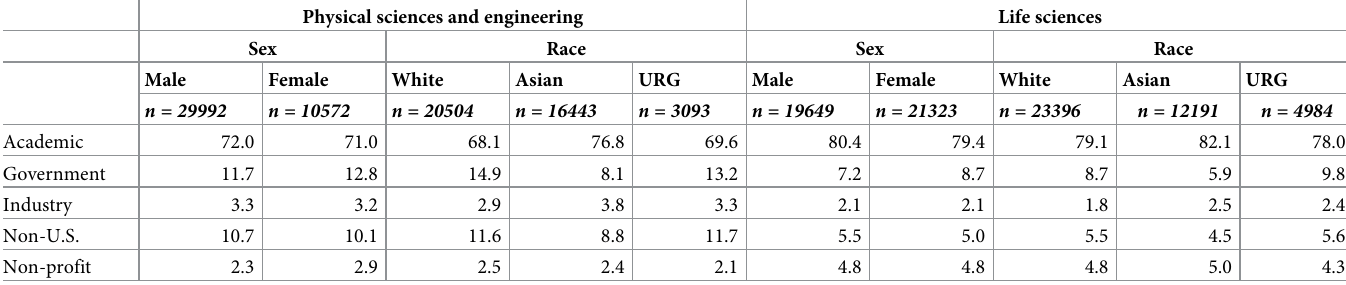
Table 3. Employment sector of postdocs (%) by sex and race from 2009 to